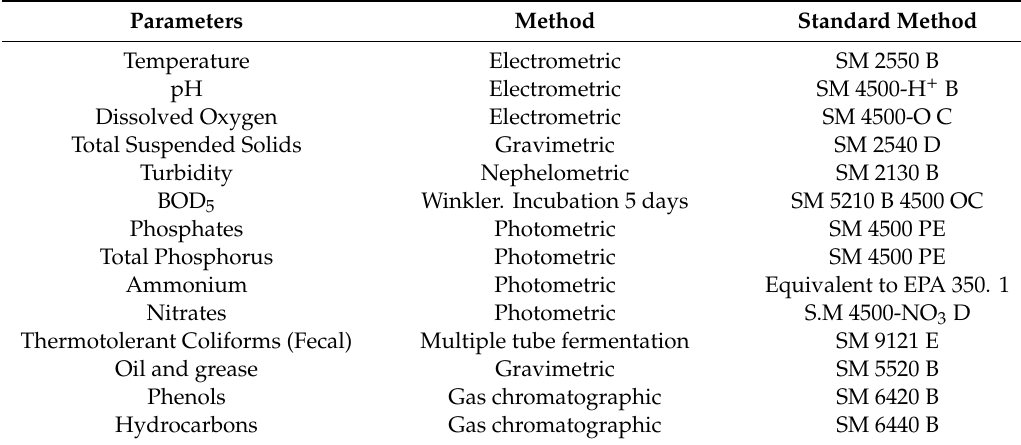
Table A1. Measurements